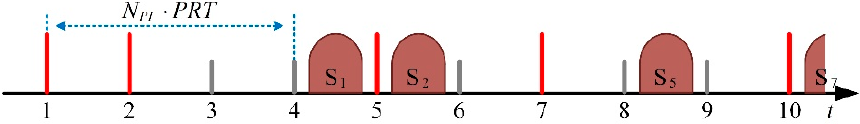
Figure 3. Timing diagram of the subswath’s pulse transmitting and receiving, where the vertical line indicates the pulse emission time, and the long red line indicates that the current pulse is assigned to this subswath. The short gray line suggests that the current pulse is assigned to other subswaths. S 1 , S 2 , and S 5 represent the reflected echoes of pulses 1, 2, and 5, respectively.